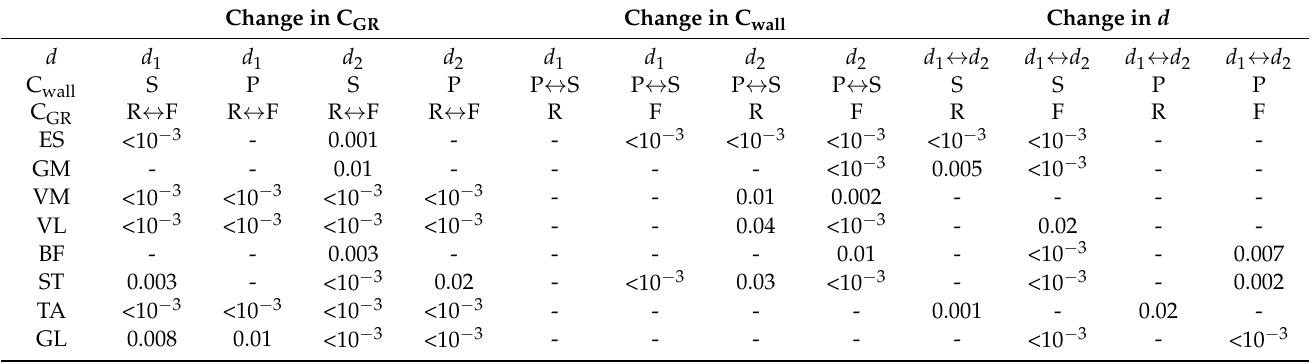
Table 3. Post hoc comparisons among different exercise conditions that differ for the value of one variable (variable 1: change in ankle–wall distance d between d 1 = 0.5 · l thigh and d 2 = l thigh ; variable 2: shift in C wall between the scapular (S) and pelvic (P) zone; variable 3: shift in C GR between rearfoot (R) and forefoot (F)). The p -value is reported only for comparisons with statistically significant differences ( p < 0.05). ES = erector spinae, GM = gluteus maximus, VM = vastus medialis, VL =